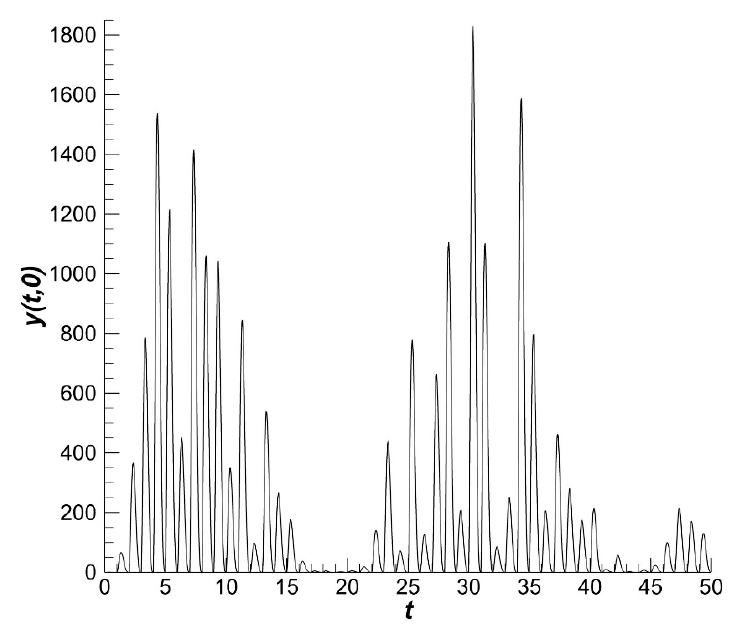
Figure 2. The recruitment density 𝑦(cid:4666)𝑡, 0(cid:4667) in stochastic scenario. Zero age corresponds to age 0+ of a young fish in our model. Condition 𝑦 (cid:2870) (cid:4666)𝑡(cid:4667) (cid:3404) 0